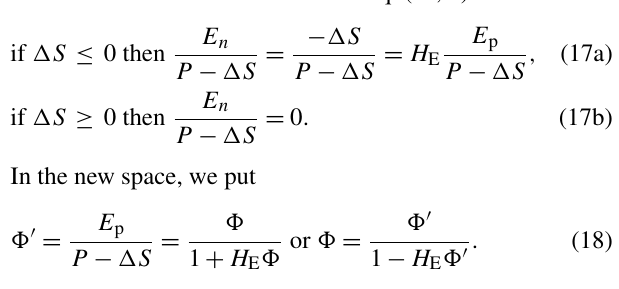
The lower limits are obtained from Eq. (7a,